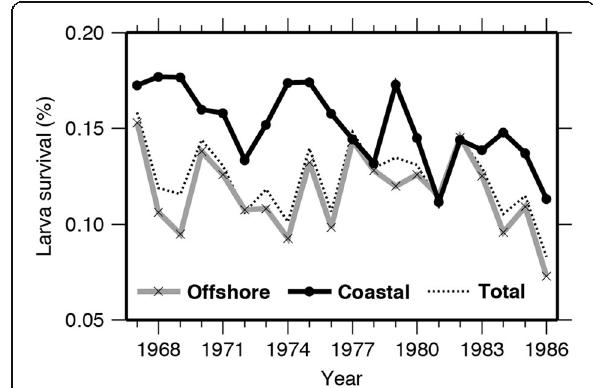
Fig. 9 Time series of simulated sardine larval stage survival. Offshore sardine larvae (gray line with crosses), coastal sardine larvae (black line with closed circles), and all sardine larvae (broken line) from 1967